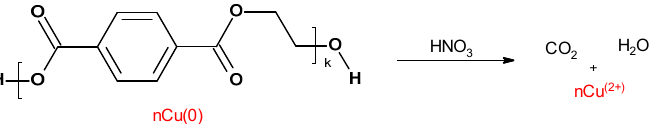
Figure 3. Mineralization of PETE-Cu (0) (k-the degree of